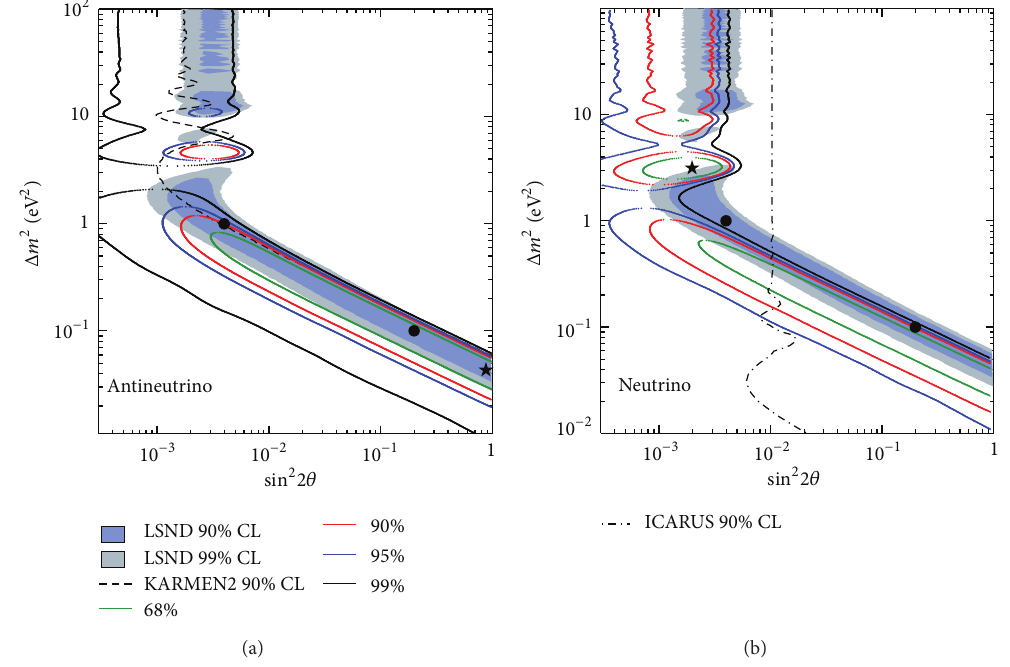
Figure14:MiniBooNEallowedregionsinantineutrinomode(a)andneutrinomode(b)foreventswithneutrinoenergygreaterthan200MeV within a two-neutrino oscillation model. Also the ICARUS [30] and KARMEN [26] appearance limits for neutrinos and antineutrinos are shown, respectively. The shaded areas show the 90% and 99% CL LSND ] 𝜇 → ] 𝑒 allowed regions. The black stars show the MiniBooNE best fit points, while the circles show two reference values in the LSND allowed region.